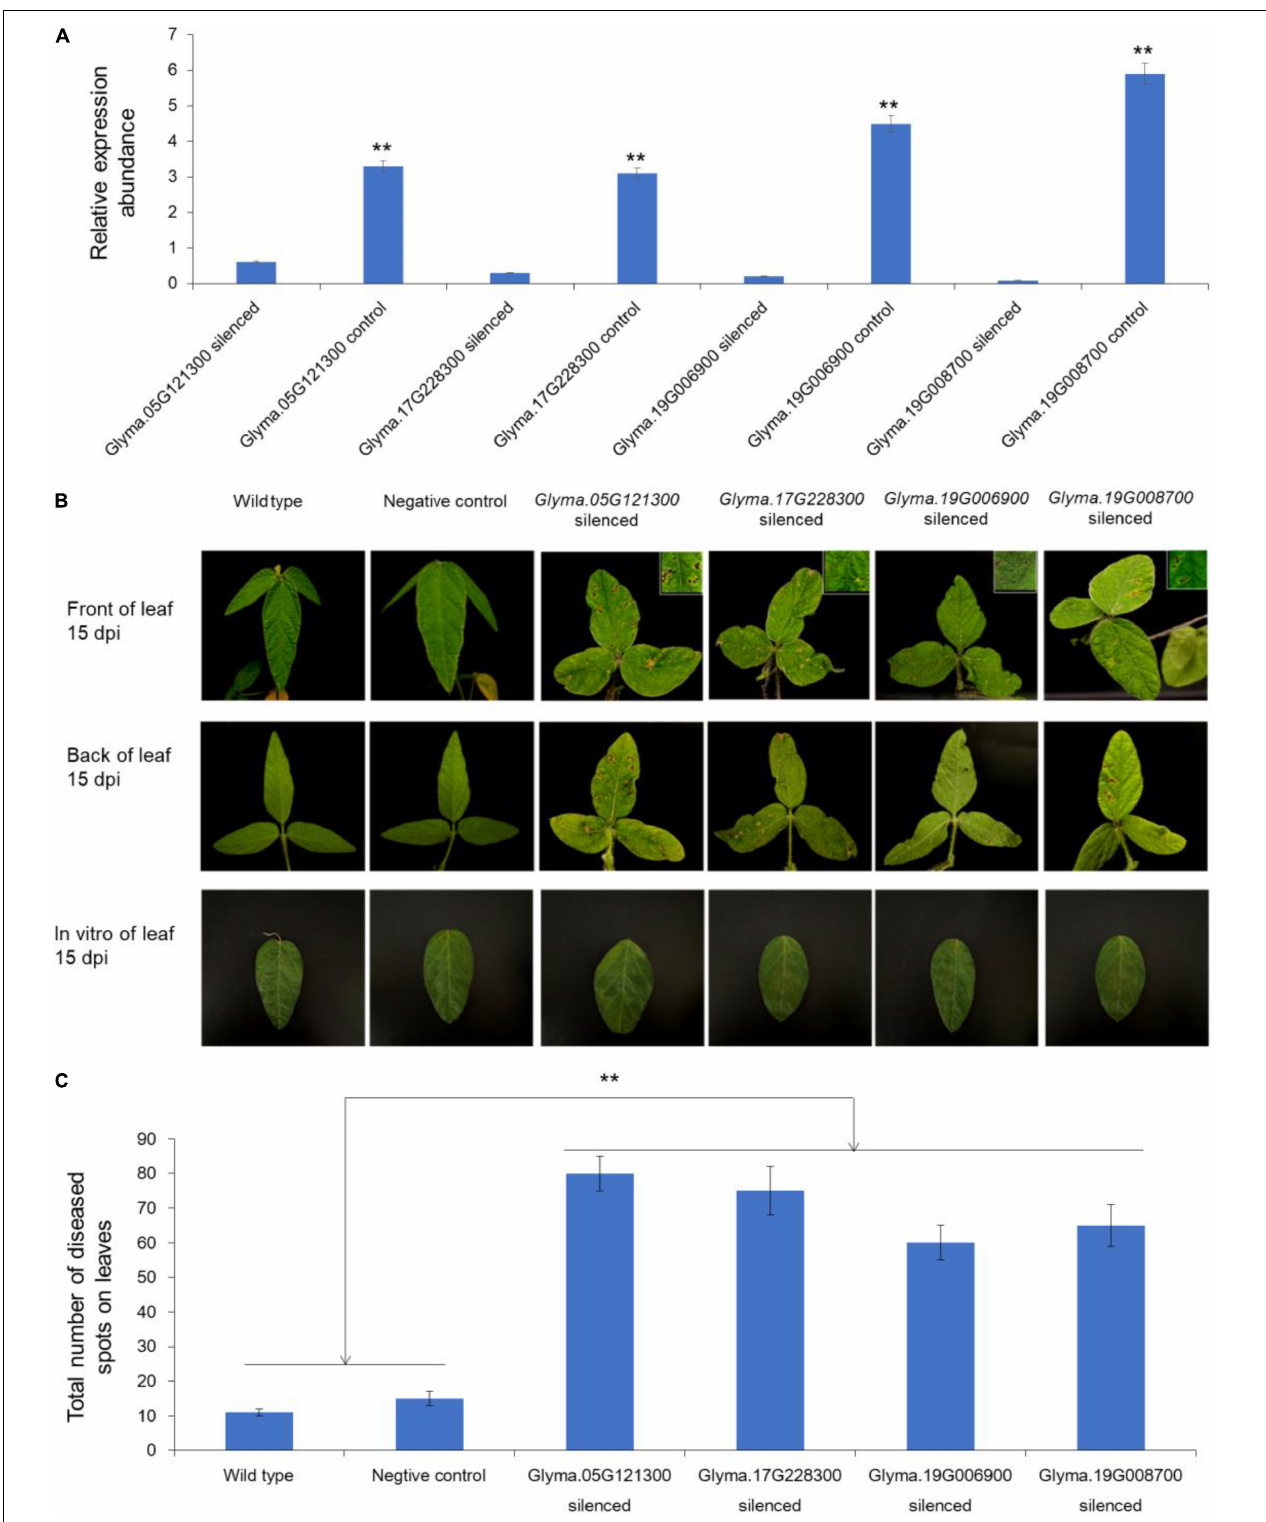
FIGURE 4 | Functional verification of candidate genes through VIGS assay. (A) Relative expression abundance of each candidate genes associated with FLS resistance in gene silenced plants and wild type plants. (B) Symptoms on the leaves of gene silenced plants and wild type plants after inoculation by Cercospora sojina Hara . (C) Total number of diseased spots on leaves of gene silenced and control plants. ** represented the significance at p < 0.01.